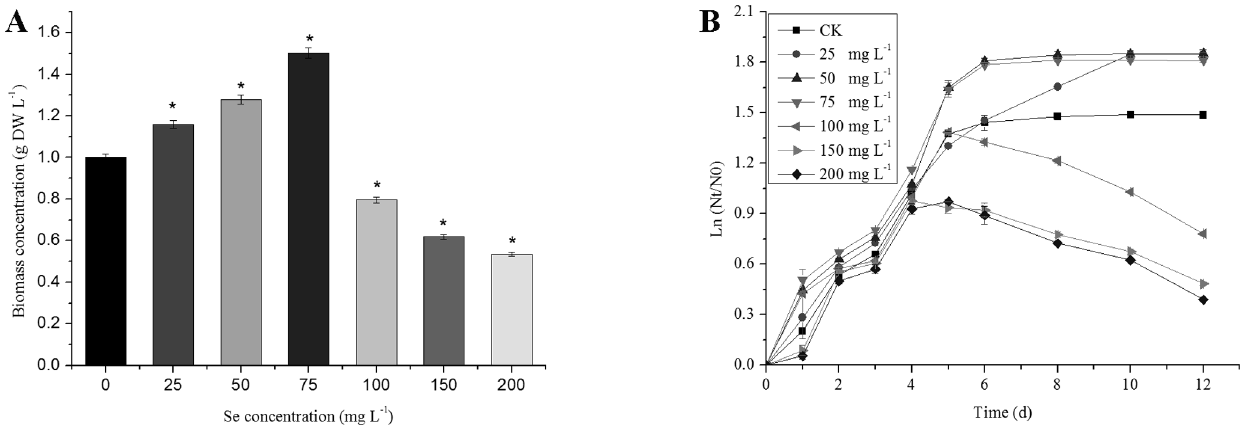
Figure 2. Effect of Se at different concentrations on biomass concentration (A) and relative growth rate (B). The single asterisk * in the figure represents significant difference compared to control ( P , 0.05). Values expressed are means 6 SD of three replicates.